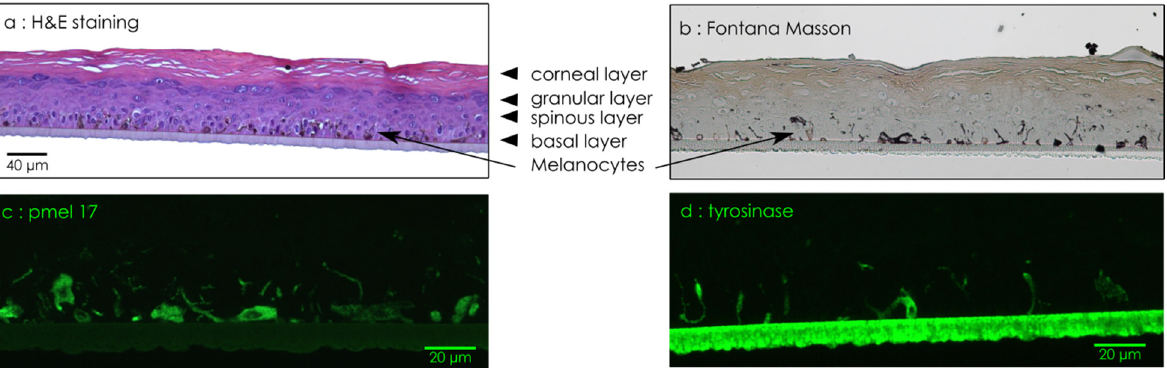
Figure 1. Microscopic observation and immunodetection of proteins in RHPE. Microscopic observation after hematoxylin/eosin staining ( a ) and melanocyte observation (dark arrows) after Fontana-Masson staining ( b ). Immunodetection of pmel17 ( c ) and tyrosinase ( d ) in melanocytes present in the basal layer of pigmented epidermis (at day 10).